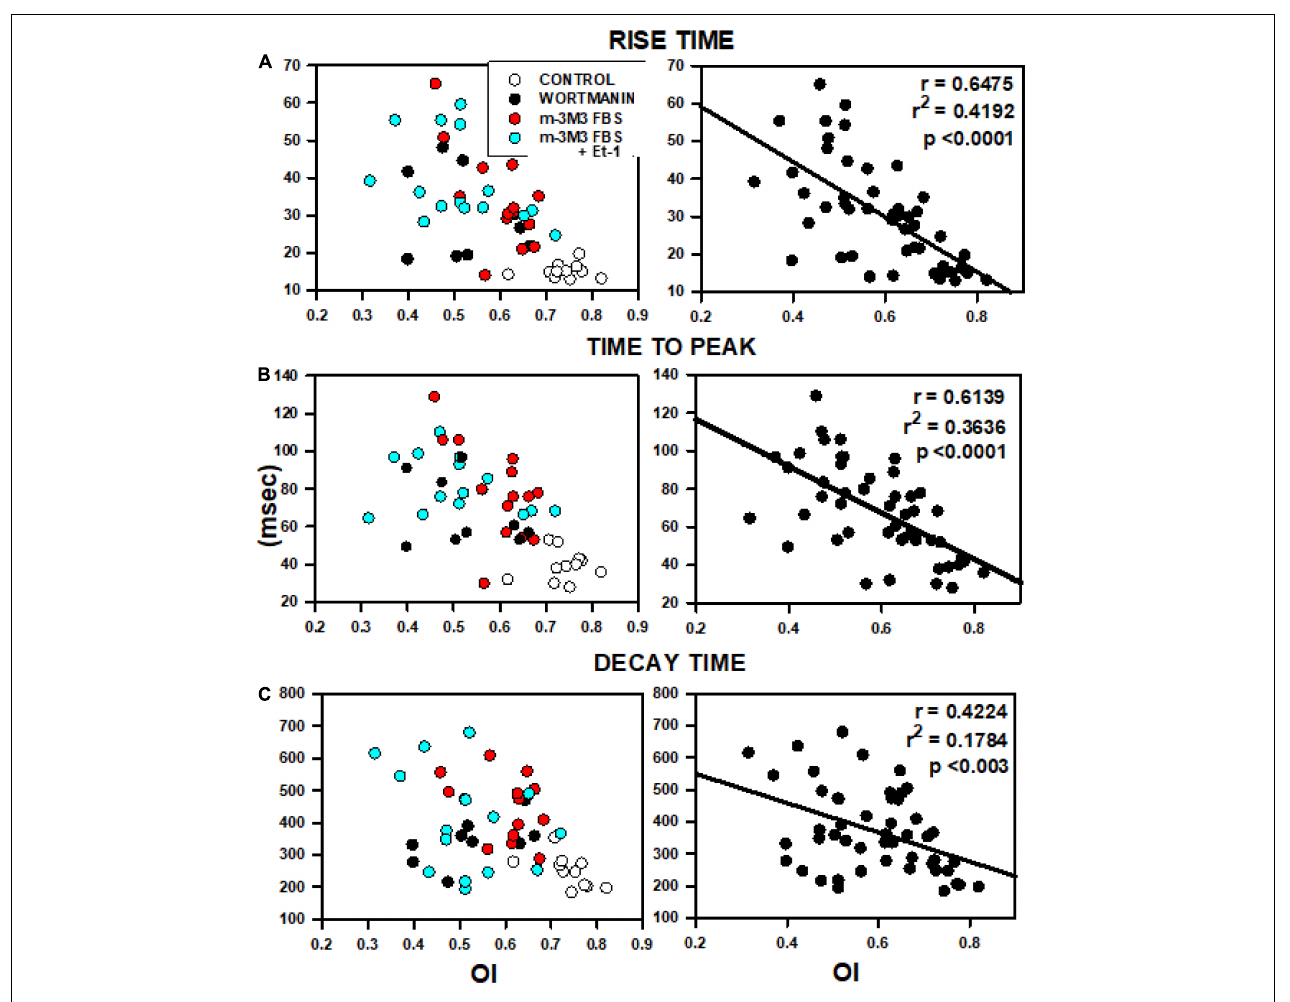
FIGURE 7 | Relationships between OI and rise time (A) , time to peak (B) and decay time (C) . Data were obtained from 5 rats from the analyses presented in Figure 6 including data from control myocytes (open circles), myocytes treated with wortmannin (filled circles), 3M3FBS (red circles) and combination Et-1 + 3M3FBS (cyan